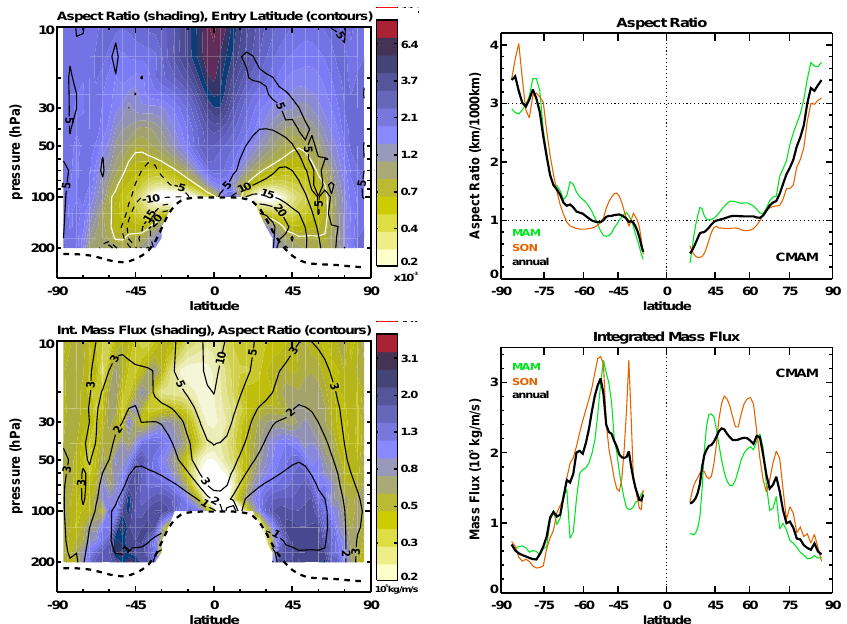
Fig. 6. Trajectory vertical to horizontal aspect ratio r (km per 1000km, top) and integrated mass flux along trajectories (in 10 5 kg/m/s, bottom) for CMAM. Left: annual means as a function of arrival pressure and latitude (color shading, note logarithmic scale). Stratospheric entry latitudes (contours, in degrees, southern latitudes dashed, zero contour omitted) and the contour r =1 · 10 − 3 (white) are overplotted in the top. Annual mean trajectory aspect ratio r (contours, in km per 1000 km, note irregular contour spacing) are overplotted in the bottom. Right: as a function of arrival latitude with arrival pressure set to correspond to Θ TP +30 K (roughly the top of the ExTL). Note stretched abscissa, which is proportional to cos ϕ to highlight extratropical areas (tropical values, equatorward of 30 ◦ , are omitted). Green: boreal spring, brown: boreal autumn, black: annual mean.